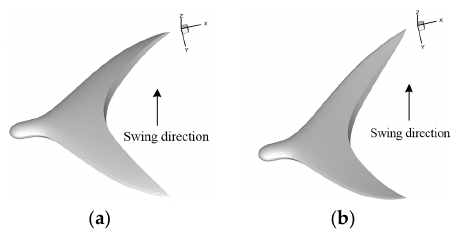
Figure 6. Shape description of the flexible crescent-shaped foil: ( a ) γ = 20°; ( b ) γ = − 20°.